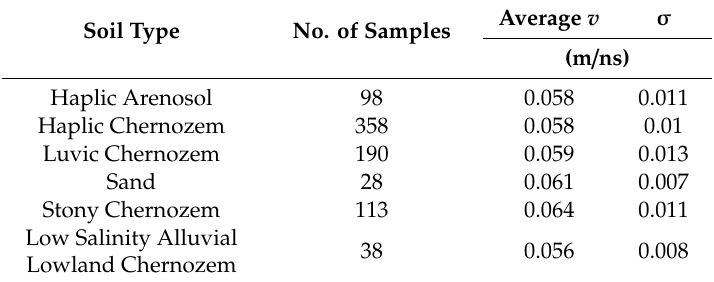
Table 3. Electromagnetic Velocities and Standard Deviation by Soil